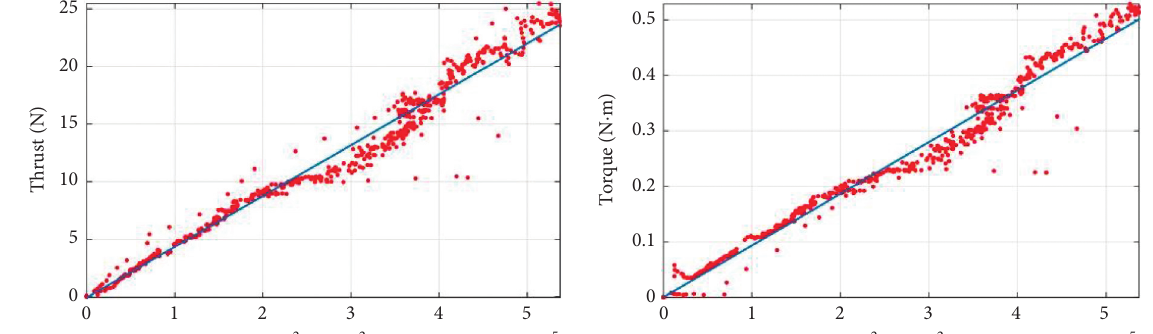
Figure 5: Test results of the rotor.